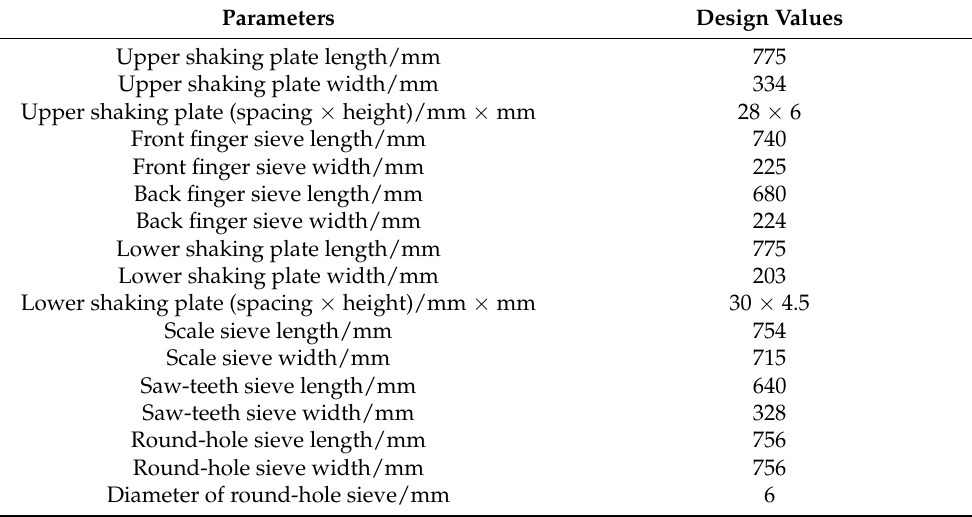
Table 3. Structural parameters of the layered impurity-controlled cleaning sieve.